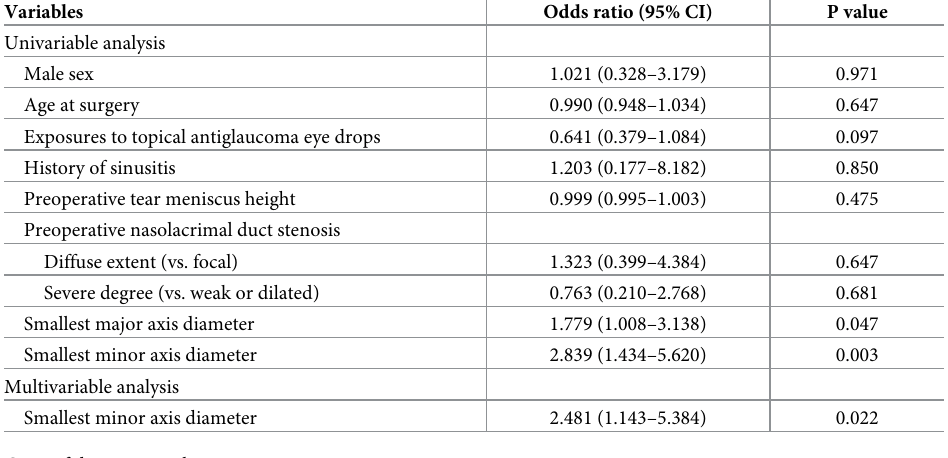
Table 3. Logistic regression analysis using generalized estimating equation for surgical success after nasolacrimal silicone